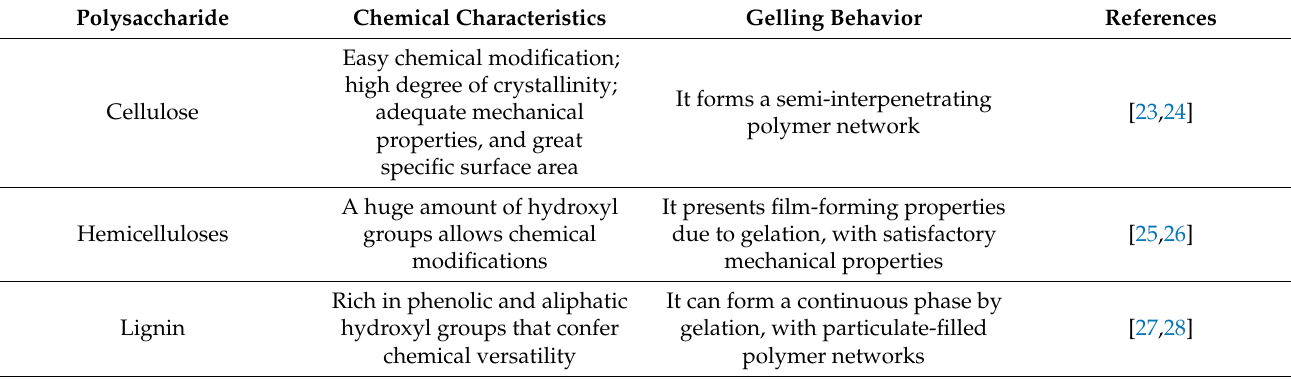
Table 1. Plant-derived polysaccharides, their types, chemical characteristics, and gelling behavior.